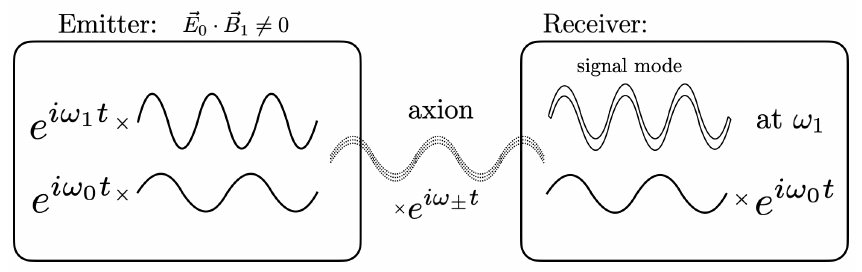
Figure 1 . A schematic sketch of the